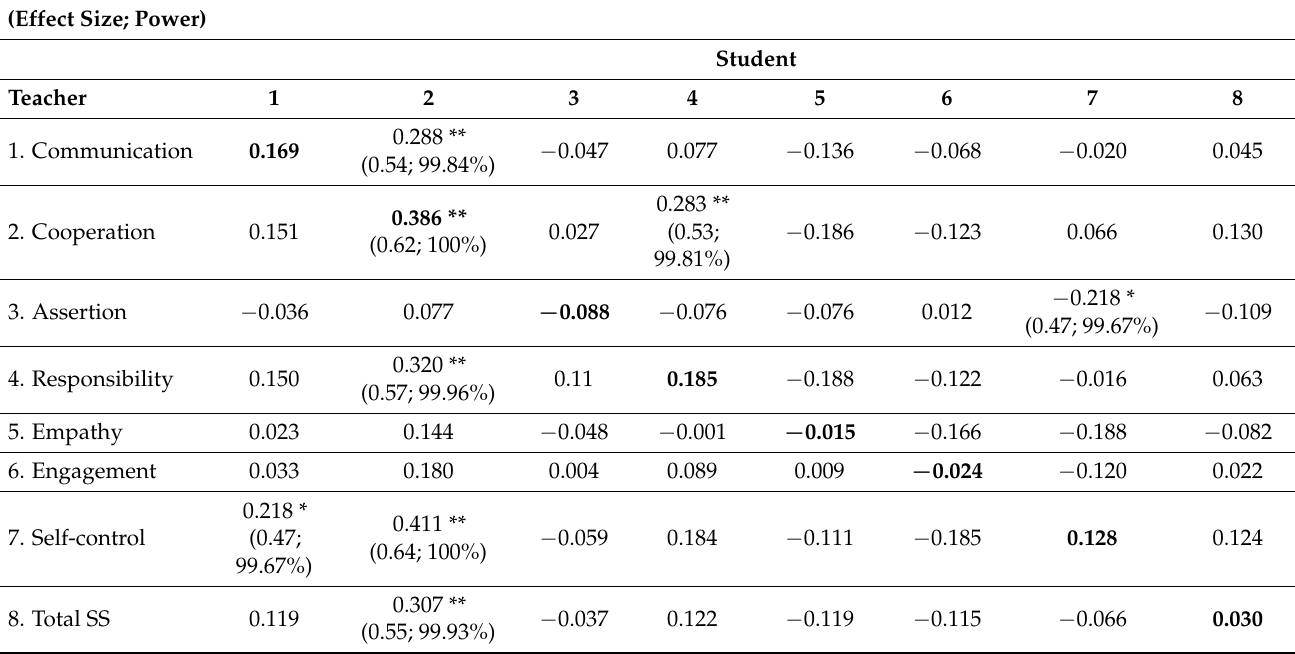
Table 7. Correlations for teacher–student (subscales and